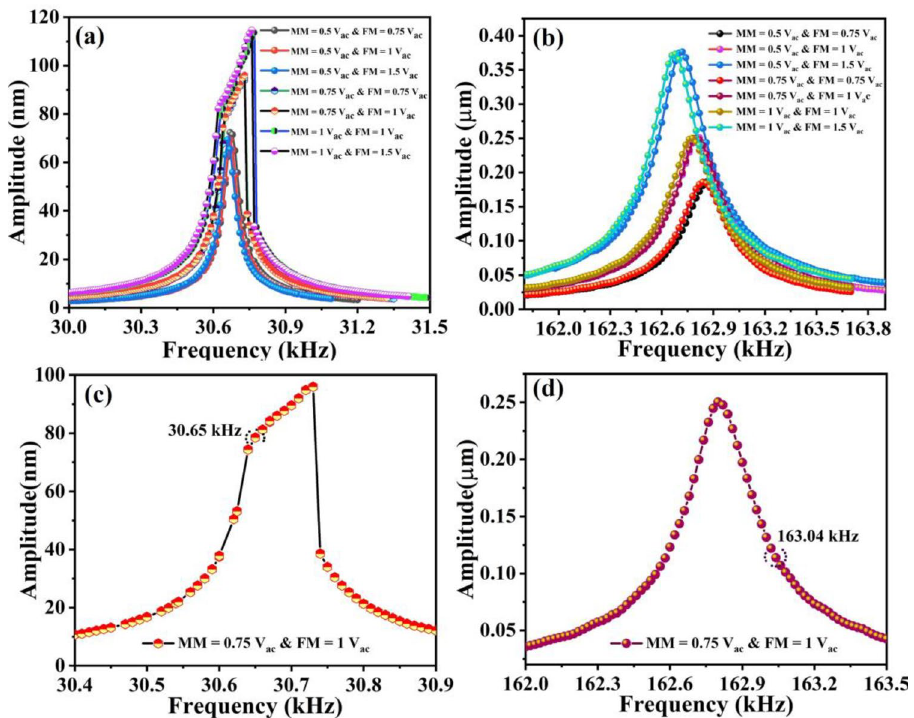
Figure 10. Frequency response curves obtained under various combinations of V ac , when both modes are simultaneously actuated, ( a ) frequency sweeping curves at the mass mode while the flexural mode was constantly actuated with a single frequency near its resonance, ( b ) frequency sweeping curves at the flexural mode while the mass mode was constantly actuated with a single frequency near its resonance, ( c ) selected frequency response curve for gas sensing, obtained after sweeping at the mass mode when the flexural mode constantly actuated with a single frequency (operating conditions V ac = 0.75 V, frequency range 30.4–30.9 kHz at the mass mode, V ac = 1 V, single frequency: 163.04 kHz at flexural mode), and ( d ) selected frequency response curve for gas sensing, achieved by sweeping near flexural mode while the mass mode was constantly excited with a single frequency (operating conditions: V ac = 0.75 V, single frequency: 30.65 kHz at the mass mode, V ac = 1 V, frequency range 162–163.5 kHz at the flexural mode).